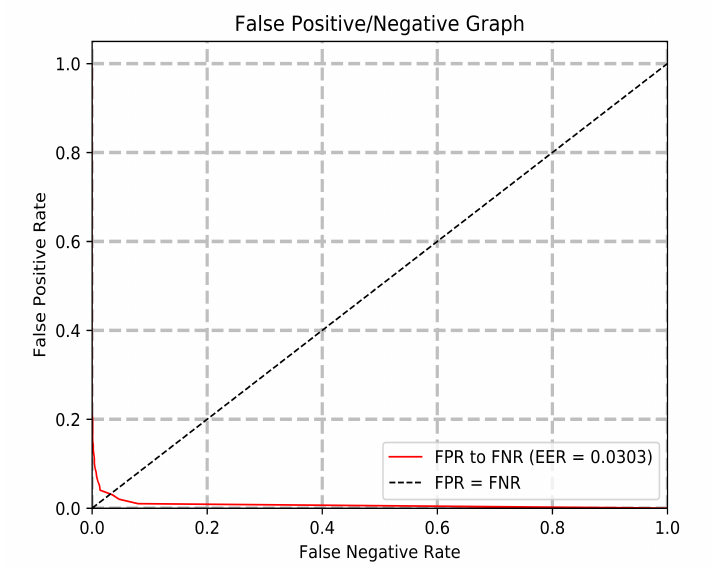
Figure 10. Receiver operating characteristic for all 200 users.